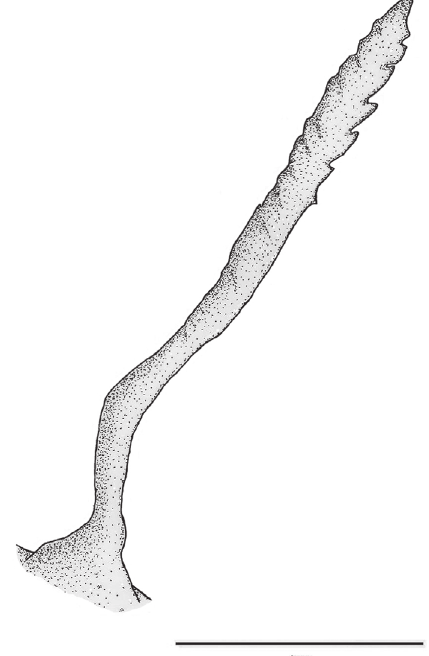
Fig. 3. Mandibular barbel of Tetranematichthys barthemi , MPEG 14565, 175.7mm SL, showing the fleshy serrated distal portion. Scale bar = 1mm.